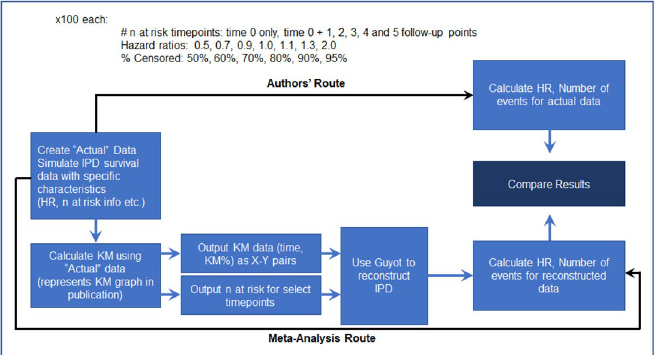
Fig 2. Simulations to verify correct implementation of Guyot algorithm: Visual illustration of simulations explored for validation of Guyot algorithm. Details can be found in S2 Appendix.